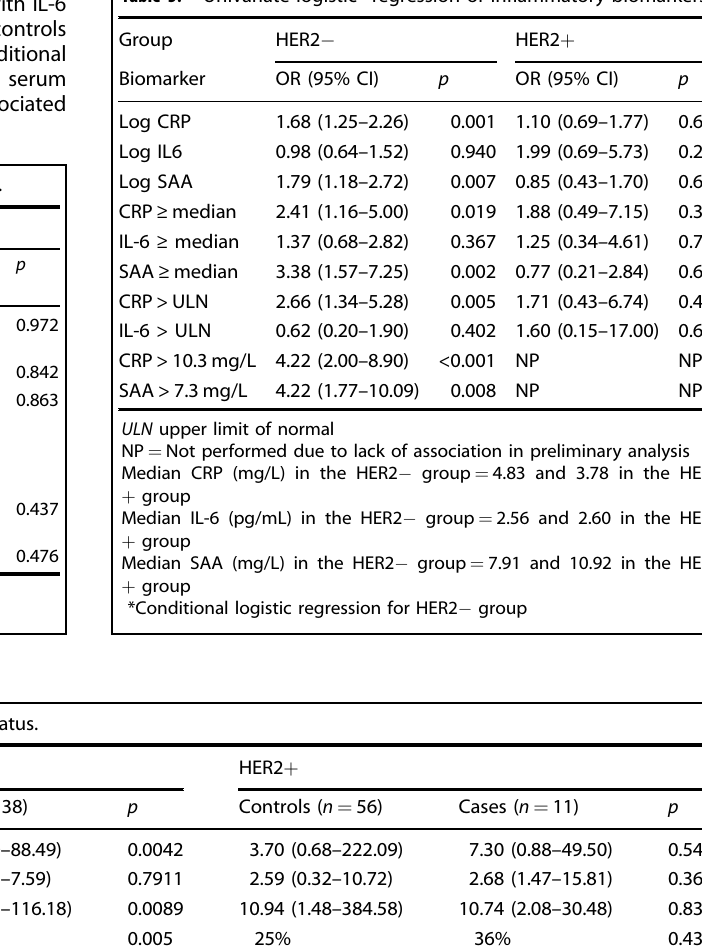
Table 3. Univariate logistic* regression of in fl ammatory